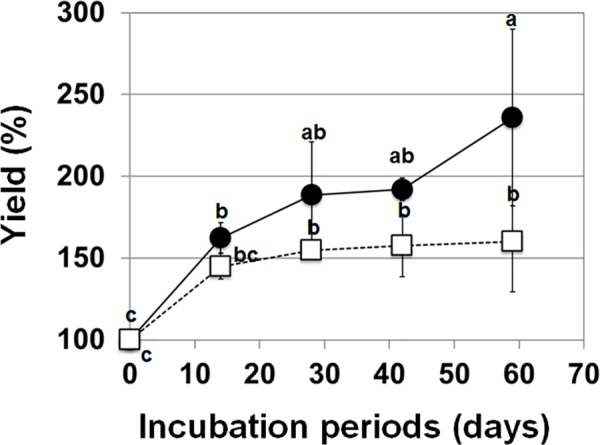
Growth profile of FEC on CIM and CIM-Ρ NPK.Growth was calculated as the percent increase in fresh weight over a 60-day period. Growth profiles of FEC on CIM (white squares) and CIM-Ρ NPK (black circles). CIM-Ρ NPK was composed of CIM with reduced content of nitrogen, phosphate, and potassium. Data represent the mean ± SD as triplicate independent measurements with two biological replicates. Values labeled with different letters (a, b and c) at all time point are significantly different by Scheff’s multiple comparison tests at P<0.05.